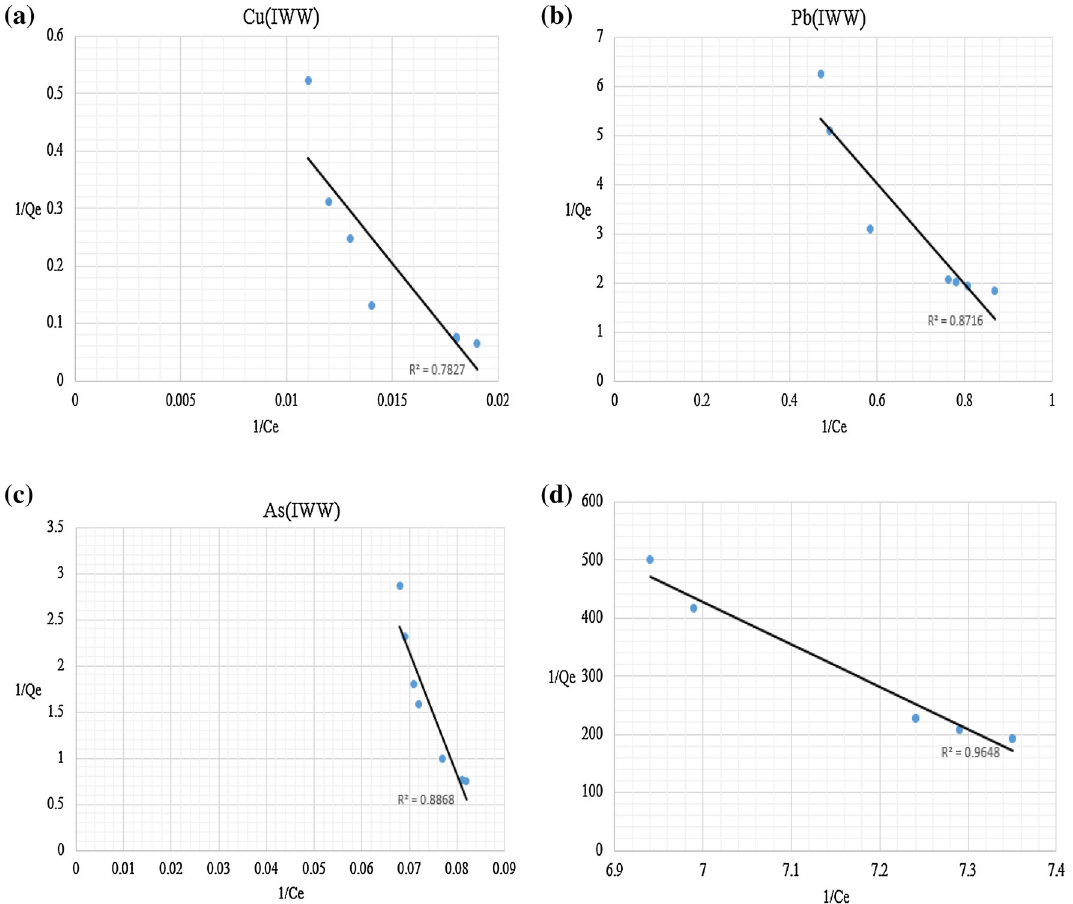
Fig. 9 Adsorption of heavy metals using Langmuir isotherm model in industrial wastewater at different proportions of B:C bioadsorbent. a Cu, b Pb, c As, d